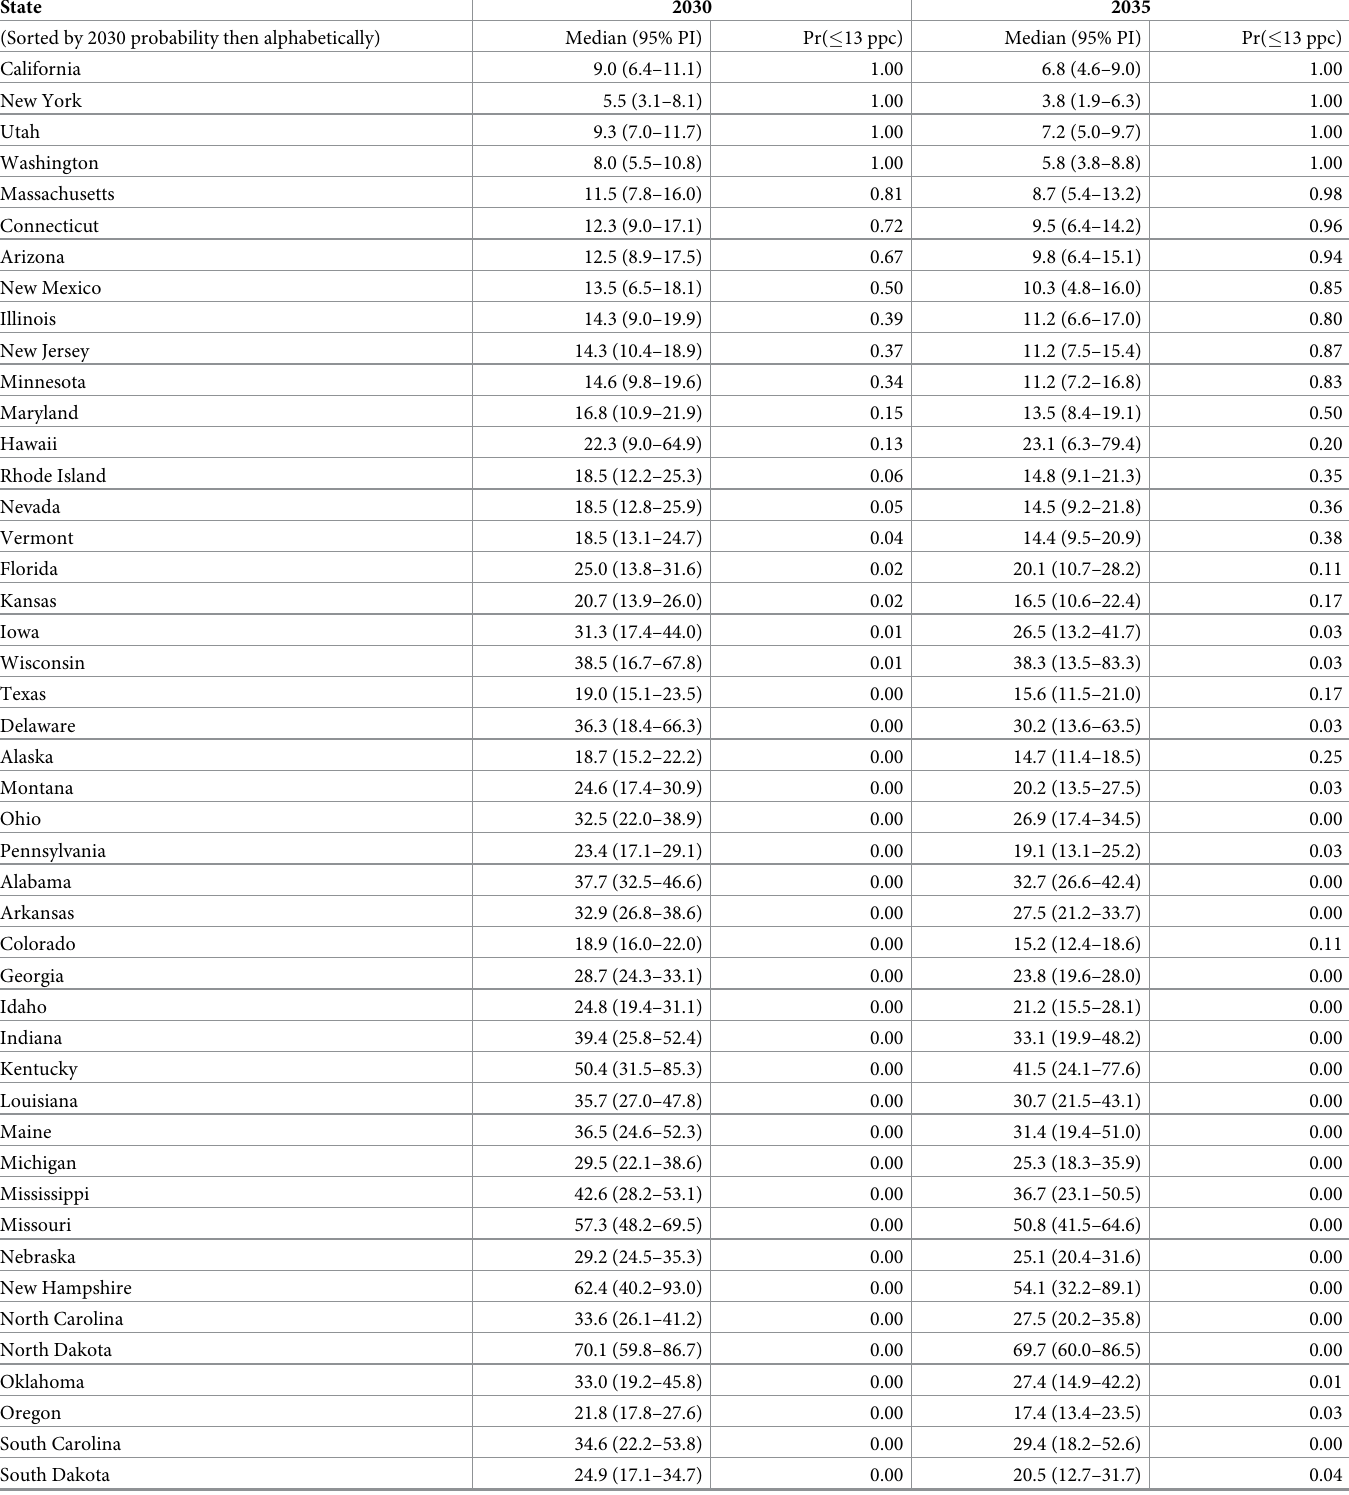
Table 2. Probability of reaching idealized target cigarette consumption by 2030 and 2035 for US